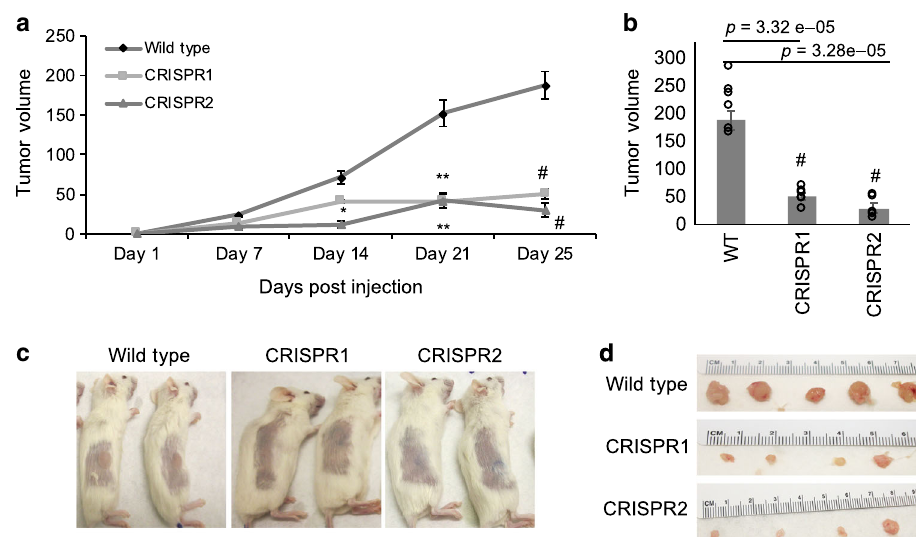
Fig. 3 RAMS11 induces tumor growth in vivo. a Signi fi cant decrease in tumor growth in RAMS11 CRISPR KO subcutaneous injected mice. Day 14 CRISPR1 p = 0.01 CRISPR2 p = 0.0002, day 21 CRISPR1 p = 0.00002 CRISPR2 p = 0.0006, day 25 CRISPR1 p = 3.32e − 05 CRISPR2 p = 3.28e − 05. b Quanti fi cation at day 25 showing decreased tumor growth in RAMS11 CRISPR KO lines compared with wild type. c Representative mice showing little to no tumor growth and d representative resected tumors from mice. Data shown as mean ± SEM and analyzed by two-tailed paired t -test, with n = 10 per group repeated two times. * p < 0.05, ** p < 0.005, # p < 0.0005. Source data are provided as a Source Data File.